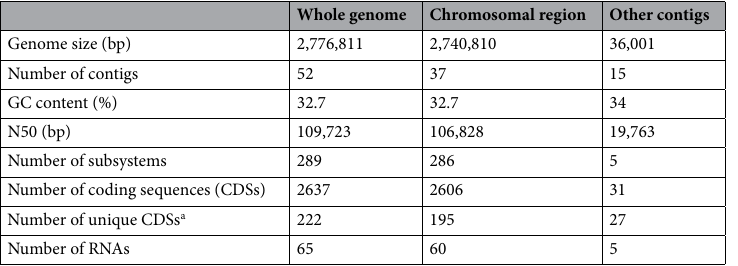
Table 1. General features of the HS-MSSA draft genome. a Identified based on sequence comparison with the NCTC8325 reference genome. Unique CDSs are present only in the HS-MSSA draft